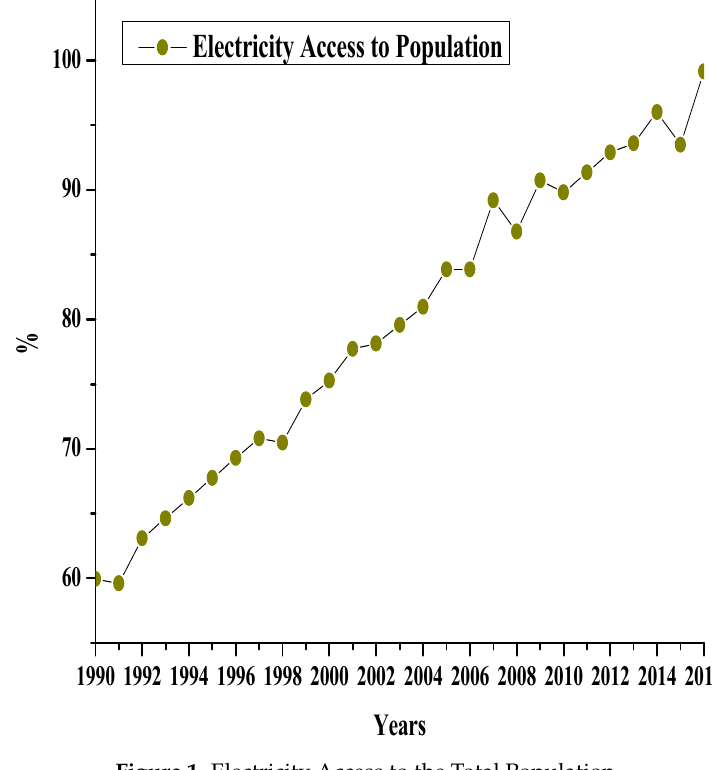
Figure 1. Electricity Access to the Total Population.